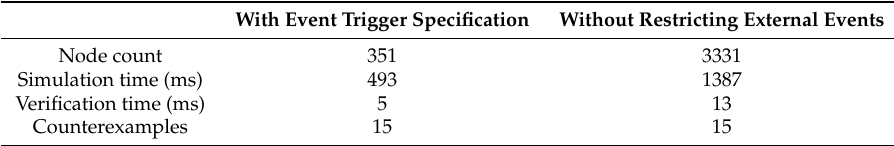
Table 3. Metrics of the Two-Tank-Pump-Consumer